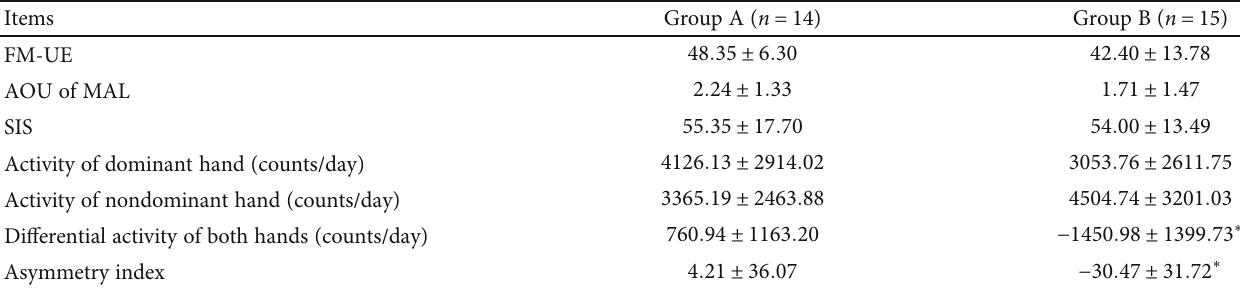
Table 3: Comparisons of FM-UE, MAL, SIS, and hand activity in both groups.